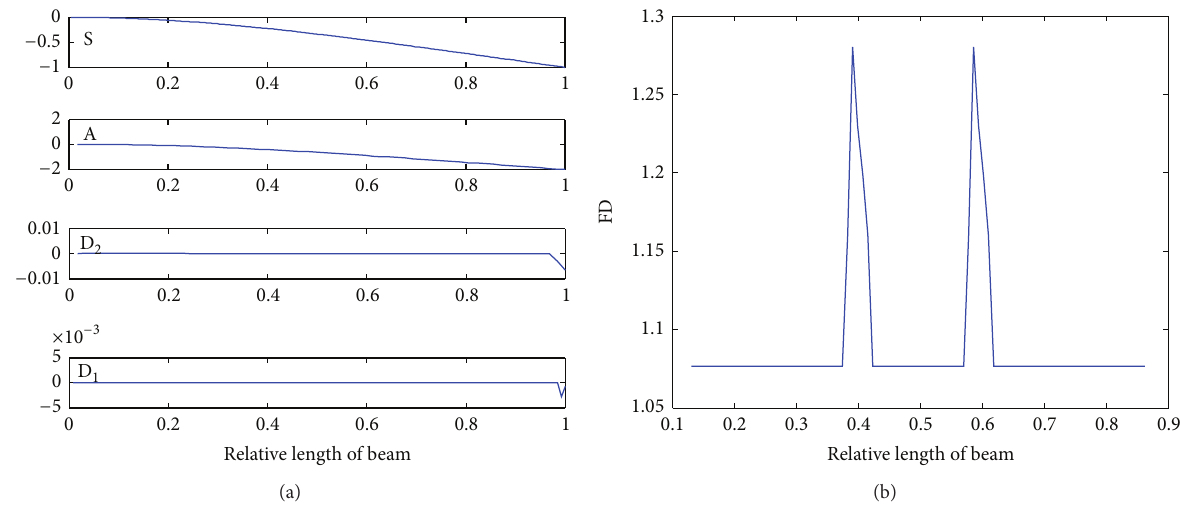
Figure 3: Crack location identification results using the proposed method for the first mode shape. (a) The first mode shape S and its wavelet decomposition at level 2. (b) FD of the detailed signal D 1